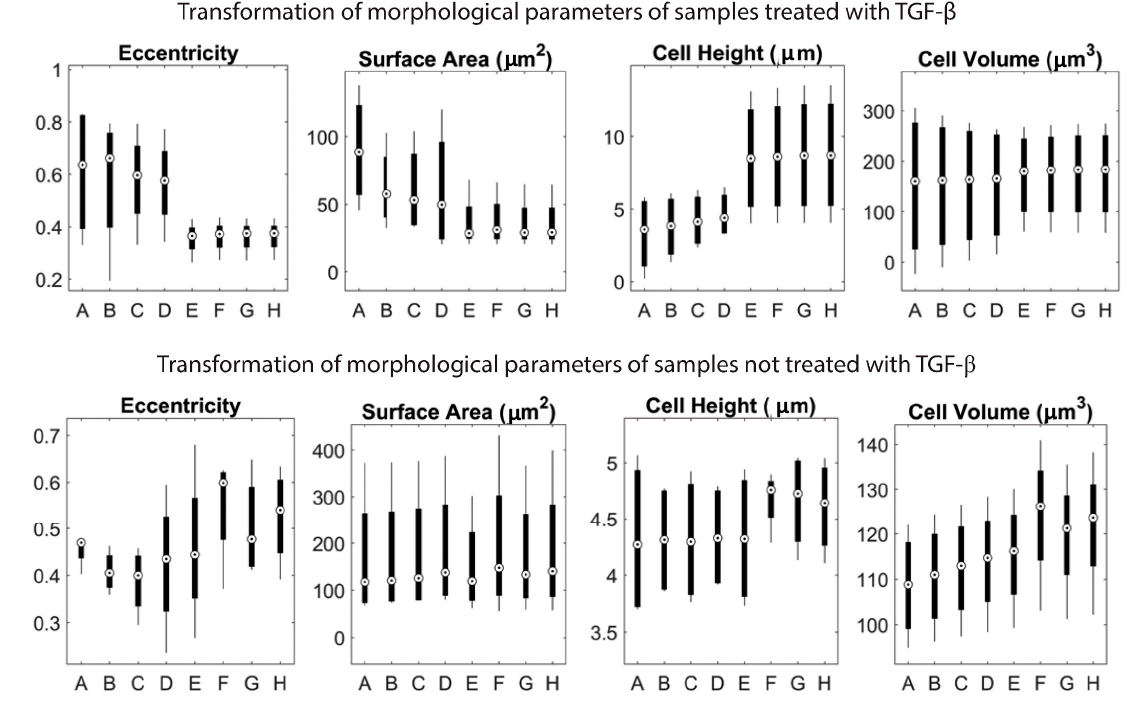
Figure 3. Eccentricity, surface area, cell height, and cell volume parameters are calculated and summarized in these graphs. Samples treated with TGF- β are given at the top graphs and the control groups are given at the bottom graph. The labels A, B, C, and D labels respectively represent HCT-116, HUVEC, ONCO-DG1, and MDA-MB-231 cells before EMT and E, F, G, and H labels respectively represent HCT-116, HUVEC, ONCO-DG1, and MDA-MB-231 cells after EMT. For each cell line, the most notable morphological change was the decrease in the eccentricity and increase in cell height parameters. Also notable is the decrease in the variance in eccentricity and surface area